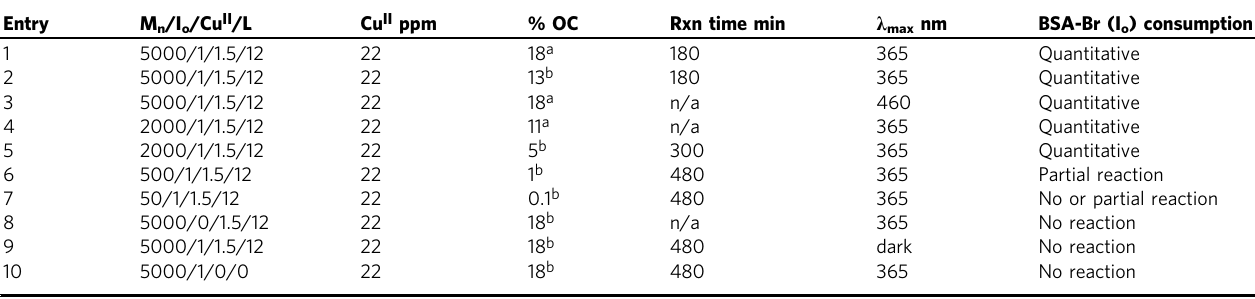
Fig. 1 General scheme and setup for the synthesis of protein-polymer amphiphiles. Top: Conventional ATRP approach and, Bottom: oxygen tolerant, photoinduced polymerization developed in this study. Table 1 Optimization of oxygen tolerant photoinduced ATRP grafting of styrene from BSA-Br.